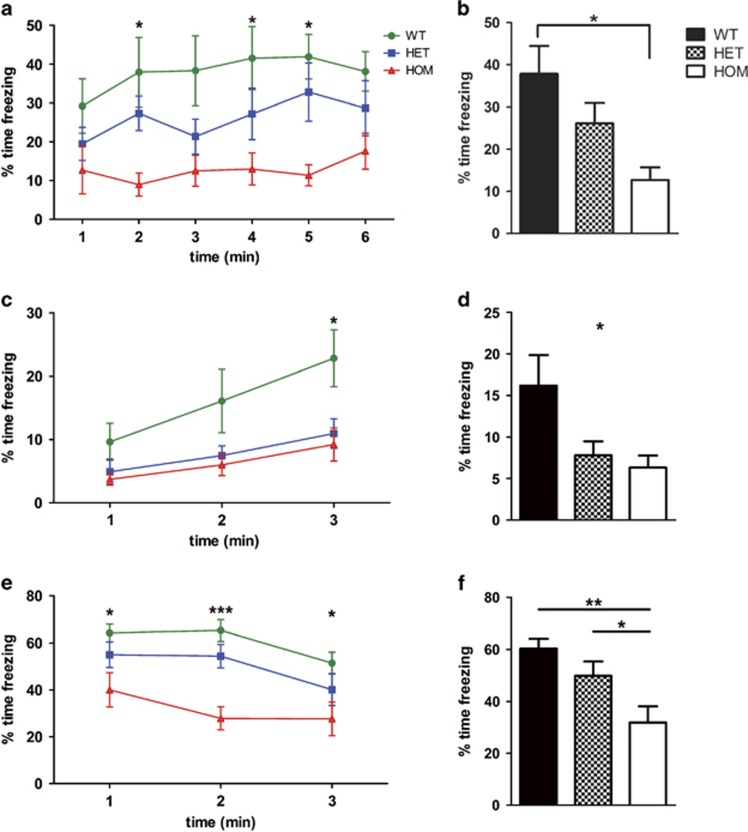
Rapgef6 deletion impairs contextual and cued fear conditioning, implying amygdala dysfunction. (a) Contextual fear conditioning had a significant effect of genotype (P=0.016) but not test time (P=0.09) with HOM mice freezing less in the original context at the second, fourth and fifth minutes (P<0.05). (b) Averaged contextual fear also had a significant effect of genotype (P=0.016), with HOM mice freezing significantly less than WT (P<0.05). (c) In the novel context, there was a significant effect of genotype (P=0.03) with HET and HOM mice freezing less than WT in the final minute (P<0.05). (d) Averaged novel context was also significantly affected by genotype (P=0.03) with no post hoc comparisons significant. (e) Cued fear conditioning had a significant effect of genotype (P=0.003). HOM mice froze less than WT at each time point (P<0.05). (f) Averaged cued fear was also significantly affected by genotype (P=0.003) with HOM mice freezing less than HET (P<0.05) and WT (P<0.01). *P<0.05, **P<0.01 and ***P<0.001. HET, heterozygous; HOM, homozygous; WT, wild type.